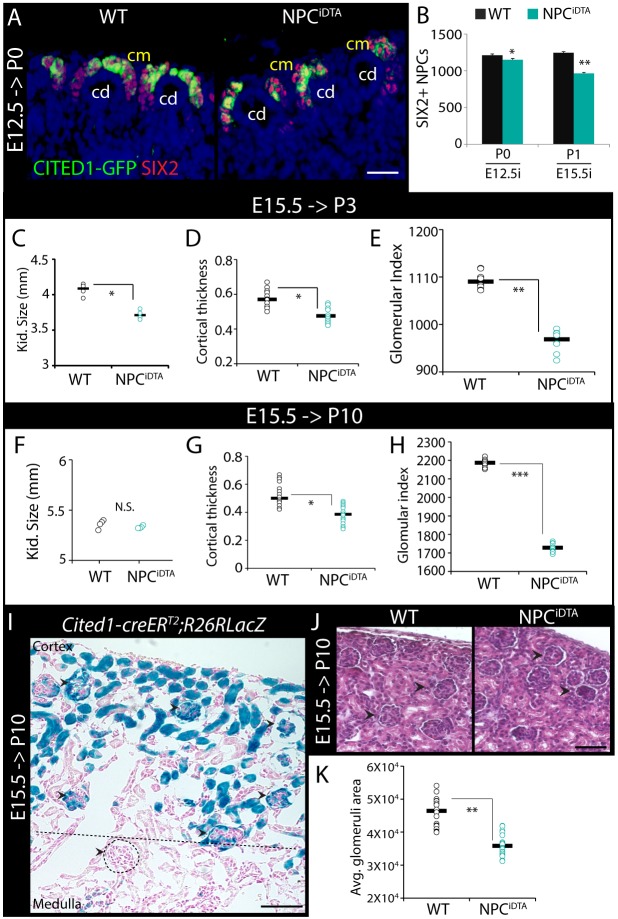
E15.5 NPC depletion causes reduced nephron number. (A,B) CITED1-GFP (green) and SIX2 (red) staining in P0 WT and NPCiDTA kidneys (A). (B) The graph shows the number of SIX2+ NPCs scored per section in P0 and P1 kidneys. Number of individual tamoxifen-treated mice analyzed per group (n)=5. E12.5i/E15.5i, tamoxifen injection at E12.5/E15.5. (C-H) Kidney size, cortical thickness and glomerular index of P3 and P10 WT and NPCiDTA kidneys. Number of individual tamoxifen-treated mice analyzed per group (n)=4. (I) X-gal-stained P10 Cited1-creERT2;R26RlacZ kidneys show that E15.5 CITED1+ NPCs largely contribute to cortical glomeruli (CG) and tubular structures. Nuclei are counterstained with Nuclear Fast Red. Black arrowheads point to X-gal+ glomeruli and dashed circle highlights X-gal– glomeruli localized in the medullary region (below the dashed line). Number of individual tamoxifen-treated mice analyzed per group (n)=3. (J,K) H&E-stained sections show CG (black arrowheads) in P10 kidneys (J). (K) Graph shows quantitation of the average area (µm2) of CG (n=20) measured per kidney section. Data represent means±
s.e.m. N.S., not significant (P>0.05), *P<0.05, **P<0.005 and ***P<0.005, 2-tailed Student's t-test. Scale bars: 150 μm (A), 200 μm (I) and 50 μm (J). cd, collecting duct; cm, cap mesenchyme. See also Fig. S2.